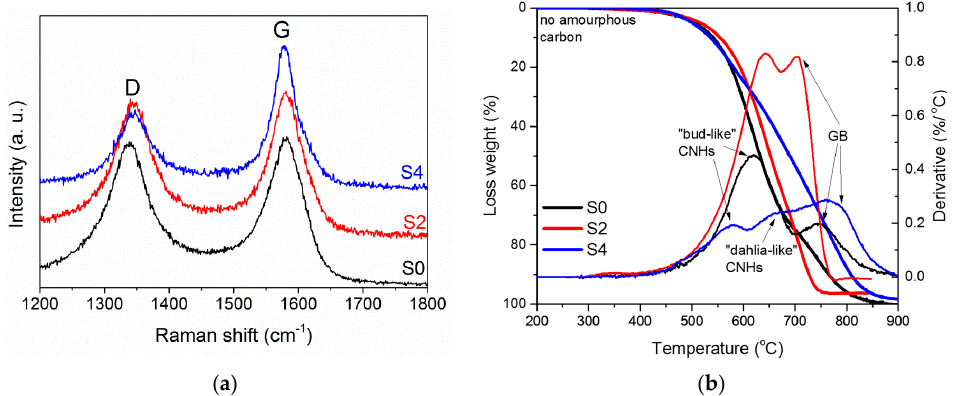
Figure 2. Raman spectra ( a ) and TG and DTG curves ( b ) for S0, S2, and S4 samples.